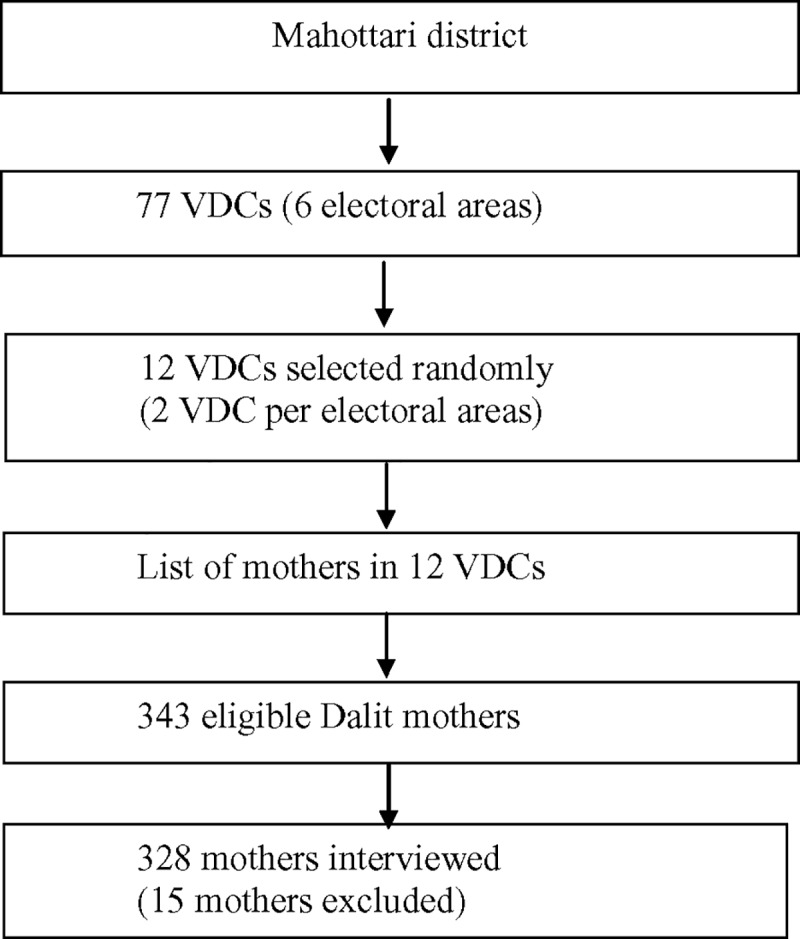
Sampling procedure.